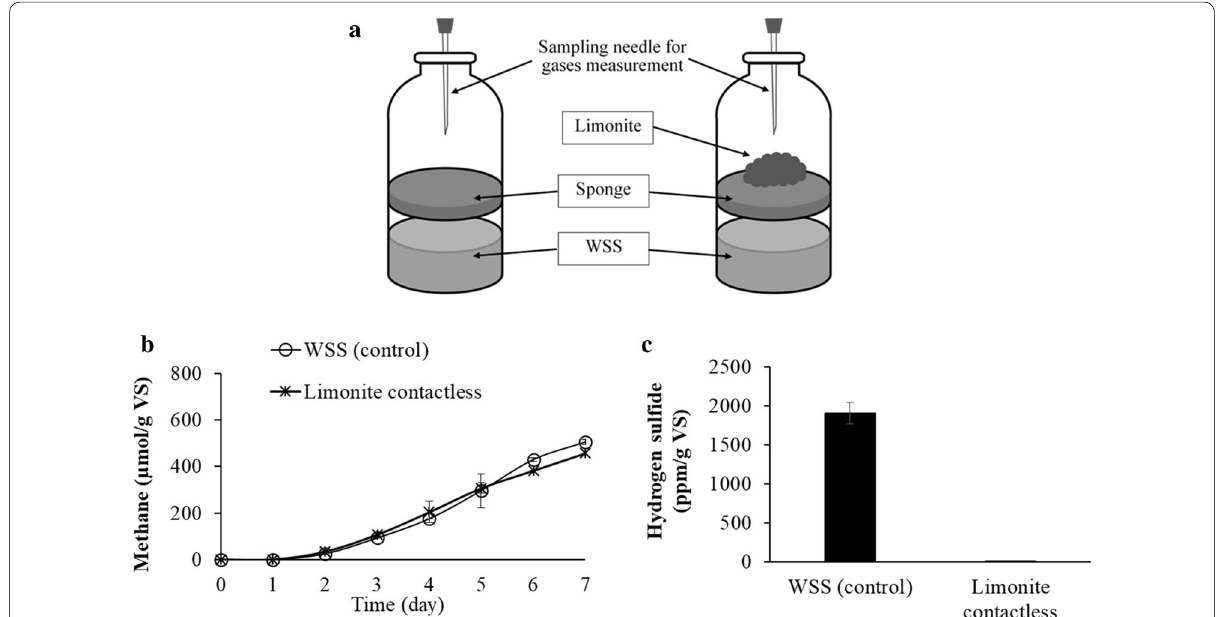
Fig. 5 Anaerobic digestion by a contactless system of WSS with or without Aso limonite. a A contactless system was constructed as illustrated. Two vials were prepared: (left) Aso limonite cannot be used for the anaerobic digestion and (right) Aso limonite cannot be mixed with WSS by separately placing it on a sponge. b Methane production and c hydrogen sulfide production from control WSS and with contactless limonite. The concentration of Aso limonite used in this experiment was 5% (w/v). Error bars represent the standard errors (n